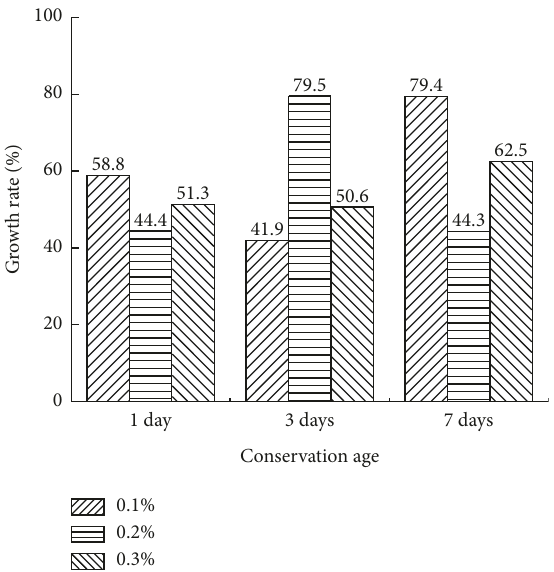
Figure 9: Change rate of the vibration number with fiber dose for cured remolded